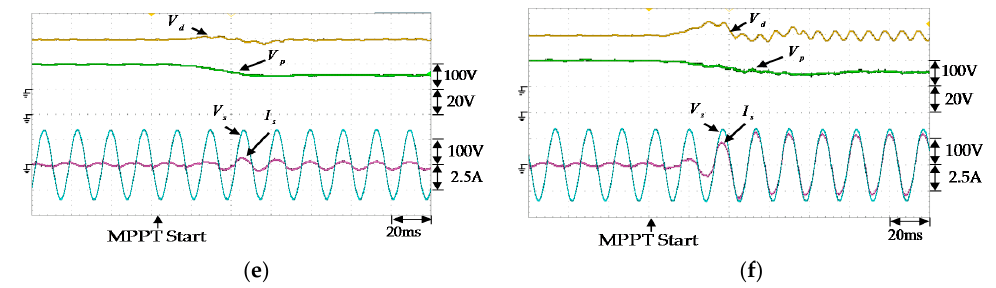
Figure 12. Experiment results of proposed two-stage MI: ( a ) DC bus voltage and output current of